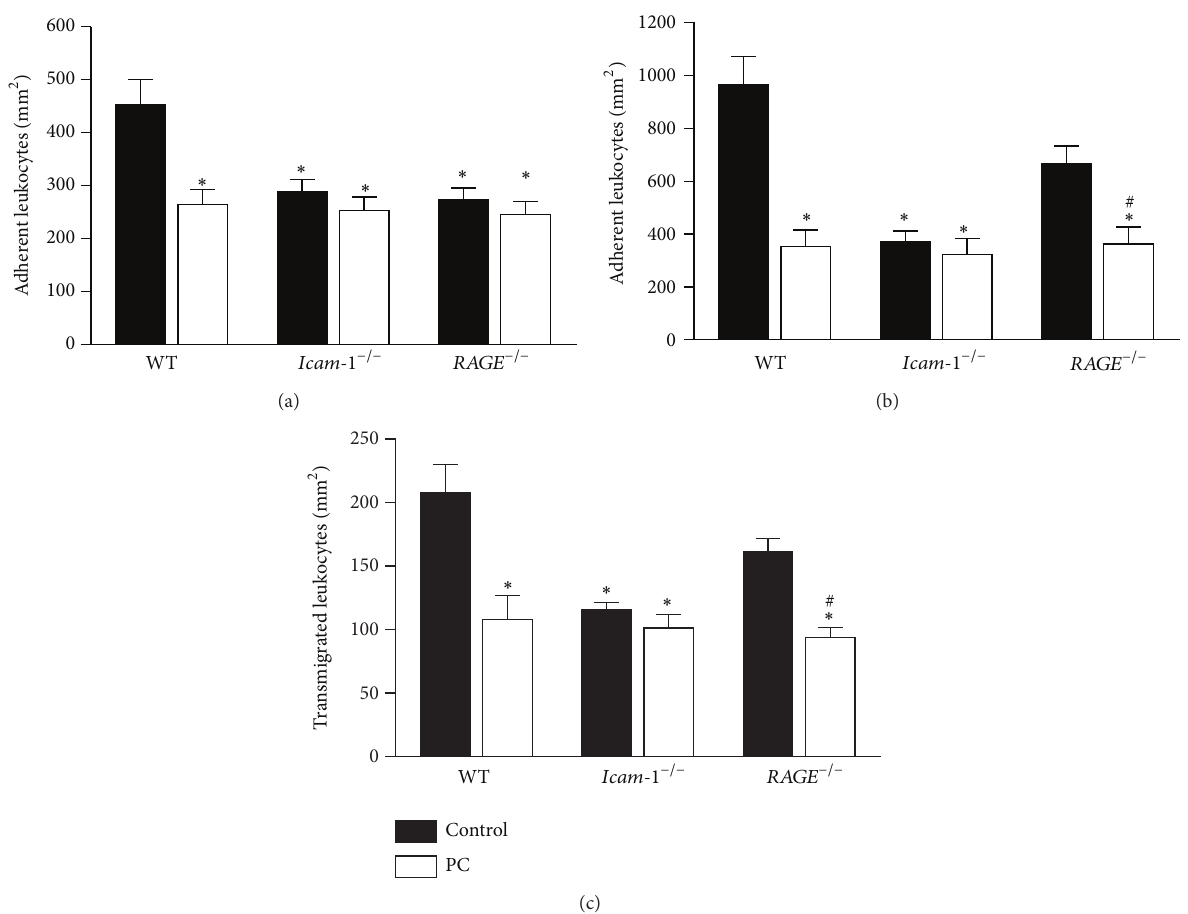
Figure 1: Effect of PC on leukocyte recruitment in wild-type, RAGE −/− , and Icam-1 −/− mice during trauma-induced inflammation. Leukocyte adhesion (number of adherent cells per mm 2 of surface area) in cremaster muscle venules of wild-type (WT) control mice, RAGE −/− mice, and Icam-1 −/− mice was recorded with and without treatment with PC (100U/kg, 3 hours) during trauma-induced inflammation (a). Leukocyte adhesion in the same genotypes and treatment groups was shown after additional stimulation with fMLP (superfusion at 1 𝜇 M, 15min) (b). Leukocyte transmigration (per mm 2 surface area) was analyzed in Giemsa-stained cremaster muscle whole mounts after 15min fMLP superfusion (1 𝜇 M) in the trauma model in WT, Icam-1 −/− , and RAGE −/− mice with and without PC treatment (100U/kg, 3 hours) (c). All values are presented as mean ± SEM from three or more mice per group. Significant differences ( 𝑃 < 0.05 ) to WT and RAGE −/− control mice are indicated by the asterisks and pound key,